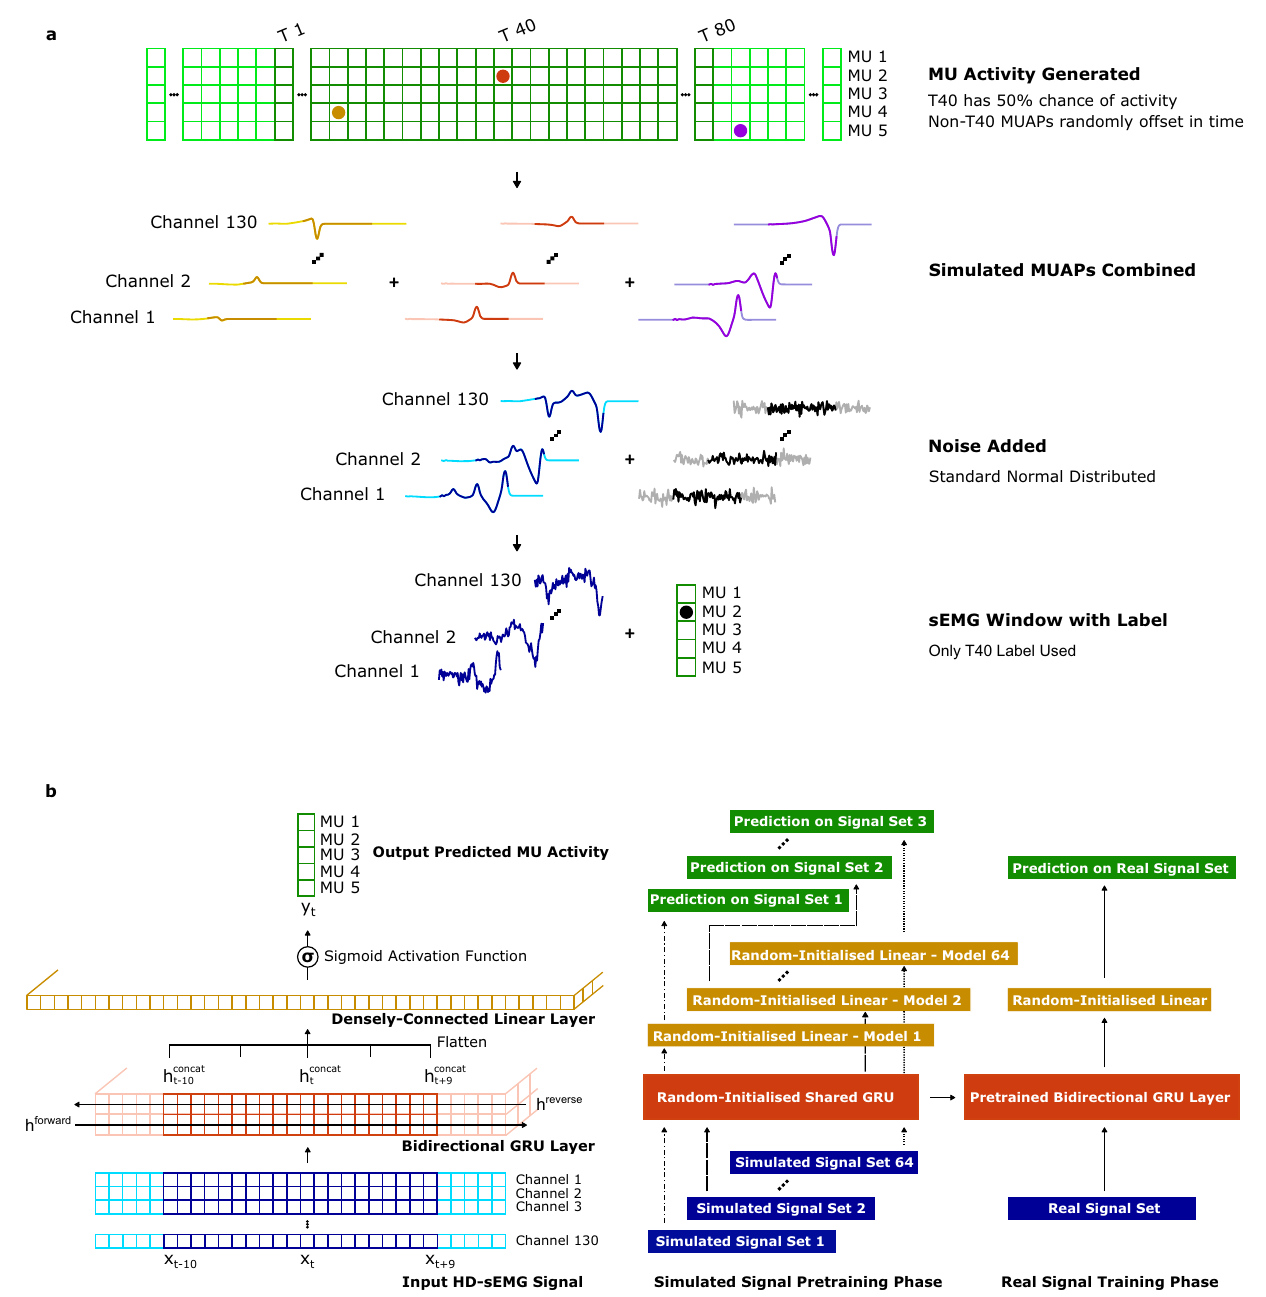
Fig. 7 | Neural network training pipeline. a Methodology used to build windows from the simulated MUAP template set for the pre-training phase. Each simulated template was 160 samples wide at a 2048Hz sampling rate and with 130 channels. First, either a MUAP template was placed in the centre of the window or it was left empty at a 50% probability. Then MUAP templates from other MU classes were added to the window at a random offset to generate superpositions. Finally, stan- dard normal distributed noise was added to the window, with the central 80 sam- ples then paired with the label for supervised learning. b The neural network